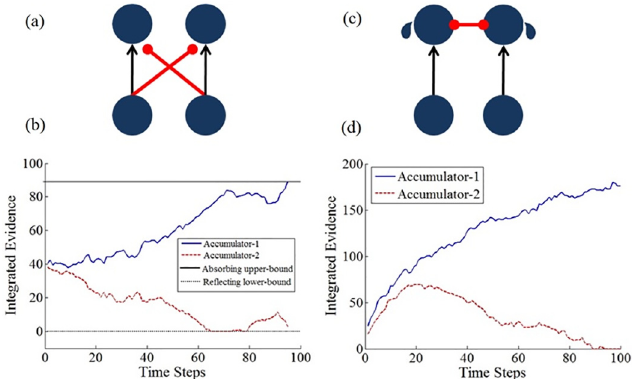
Gaussian noise) for the two models.